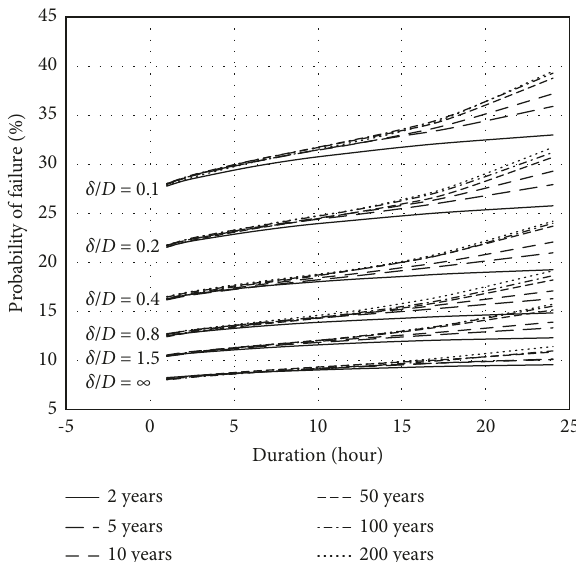
Figure 12: Change in the probability of failure depending on the return period and the rainfall duration.